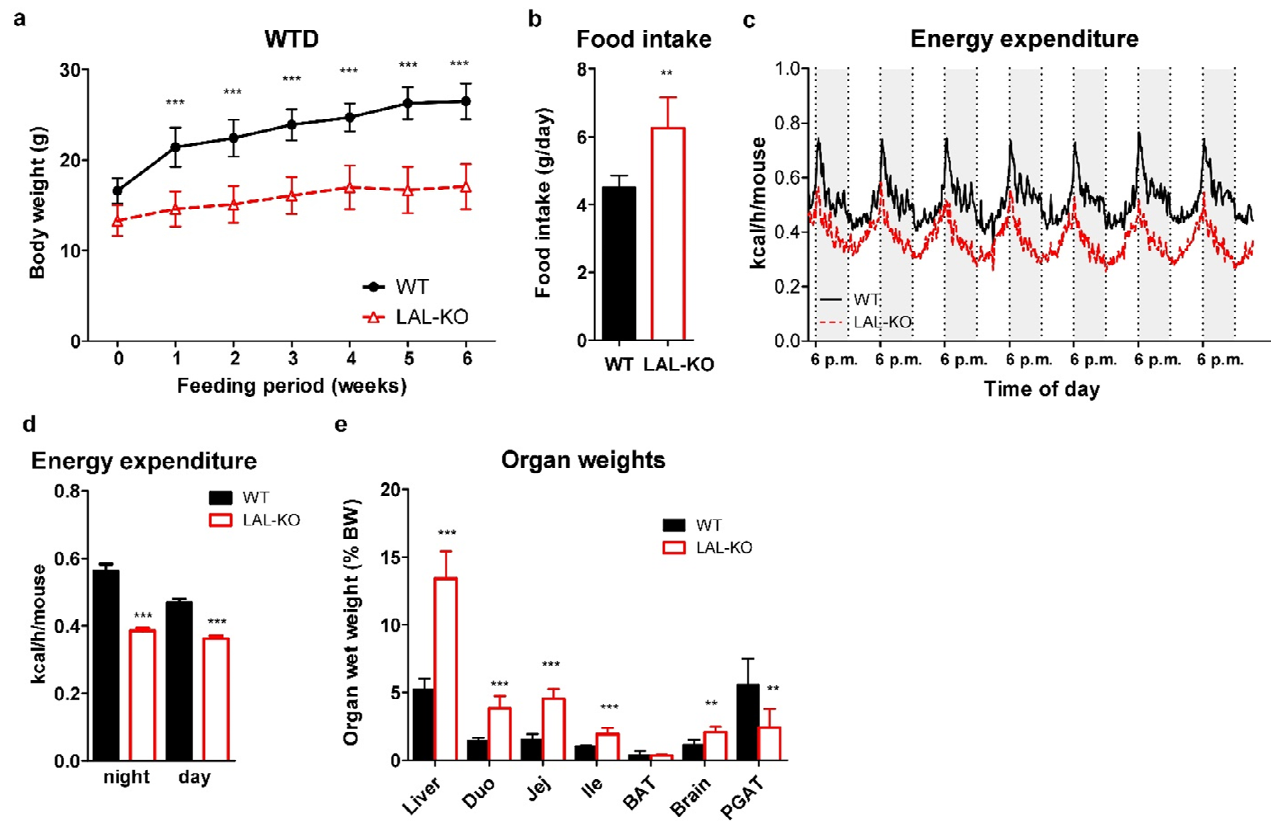
Figure 1. Resistance to diet-induced obesity and altered energy metabolism in LAL-KO mice: ( a ) Body weight of 12-week- old male mice during a WTD feeding period of 6 weeks and ( b ) daily food intake. ( c , d ) Energy expenditure measured by indirect gas calorimetry in WTD diet-fed WT (n = 6, black line) and LAL-KO mice (n = 6, red line); shaded areas represent dark phase (6 p.m.–6 a.m.); non-shaded, light phase (6 a.m.–6 p.m.). ( e ) Organ weights relative to body weight (Duo, duodenum; Jej, jejunum; Ile, ileum; BAT, brown adipose tissue; PGAT, perigonadal adipose tissue; n = 6). Data represent means ± SD; n = 6; p ≤ 0.01 (**), p ≤ 0.001 (***). ( a ) ANOVA; ( b , d ) Student’s unpaired t-test.